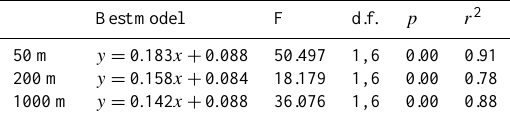
Table 4. Results from regression analyses of VSG against each of the three window sizes with Gwydir